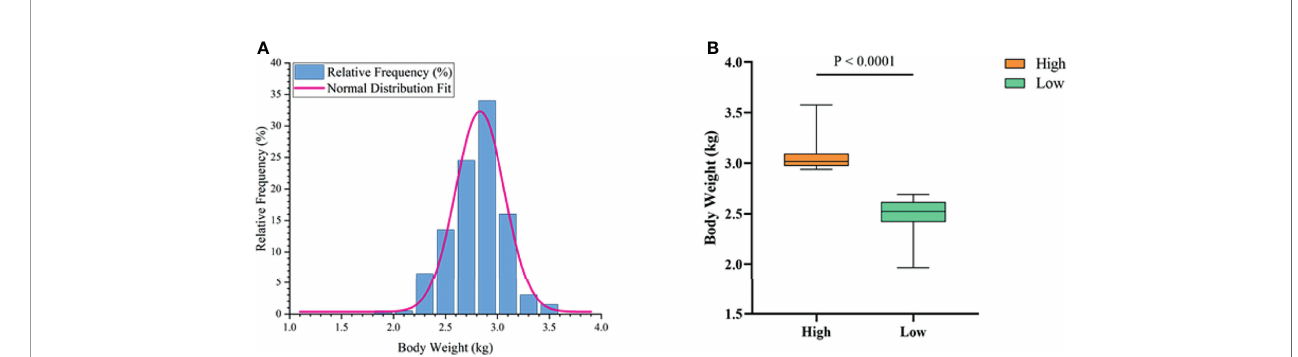
FIGURE 2 | The phenotype of Muscovy Ducks. Two hundred newly hatched ducklings were fed commercial feeds for 70 days before being weighed individually and collected the ileal segment and contents after dissection. The highest 20% and the lowest 20% of the BW-ranked ducks were set as the high and low groups from the 200 Muscovy ducks, respectively. The test of a normal distribution on the BW (A) and the phenotype of BW (B) in high and low groups. Data were expressed as mean ± SD (n = 40) and analyzed by unpaired two-tailed Students